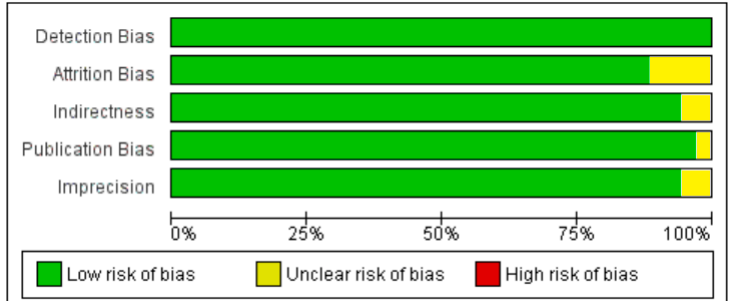
Figure 6. Summary of risk of bias assessment for non-diabetic subject studies, data shown are in percentages.